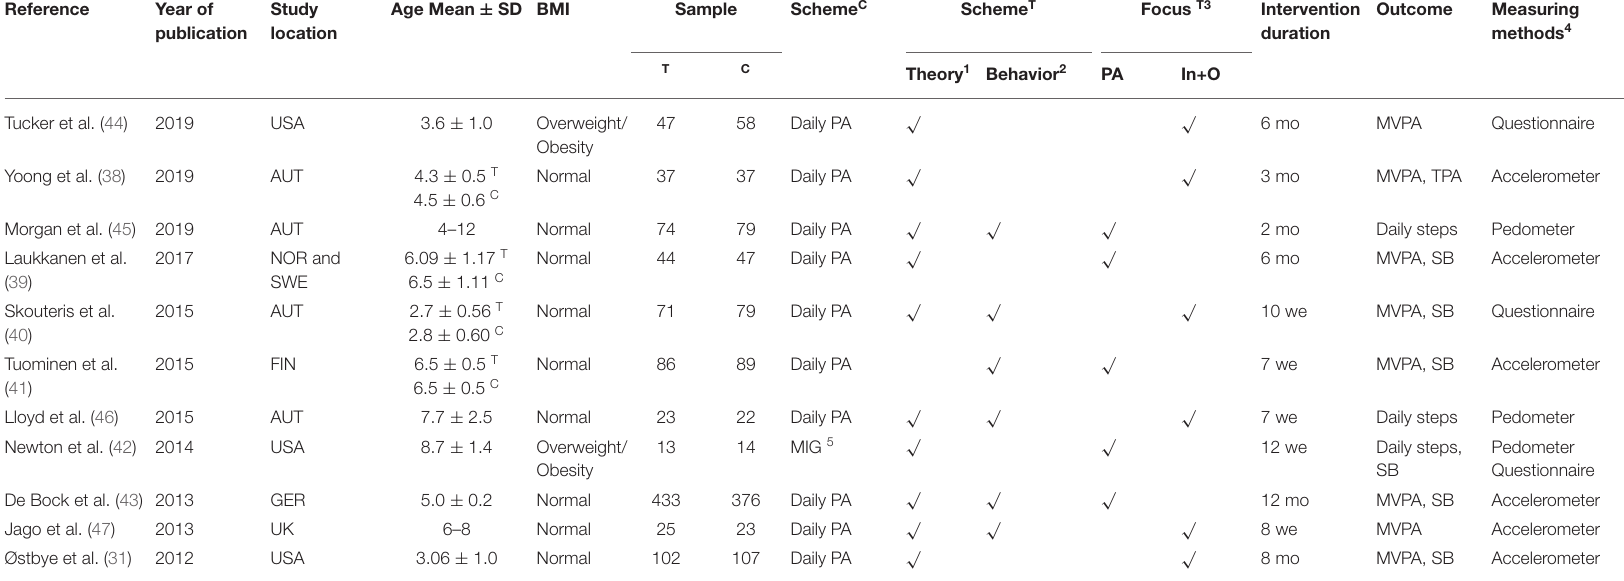
TABLE 1 | Characteristics results of a meta-analysis on the family intervention on PA and SB in children aged 2.5–12 years.